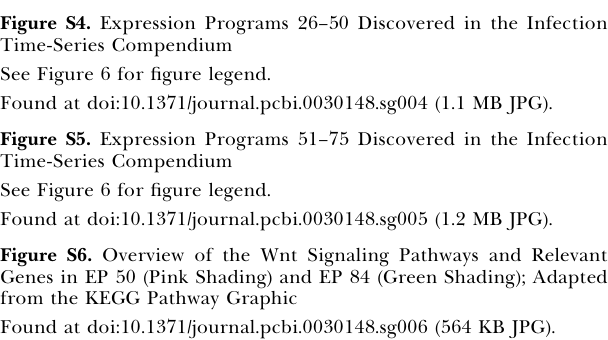
Table S1. Summary of Data Sources Used in the Infection Time- Series Compendium Table S2. Summary of Individual Experiments in the Infection Time- Series Compendium Table S3. Details for All 104 Expression Programs Discovered in the Infection Time-Series Compendium Table S4. Summary of Selected GO Biological Process Categories and KEGG Pathways for Which Expression Programs Discovered in the Infection Time-Series Compendium Were Significantly Enriched Table S5. Complete List of GO Biological Process Categories and KEGG Pathways for Which Expression Programs Discovered in the